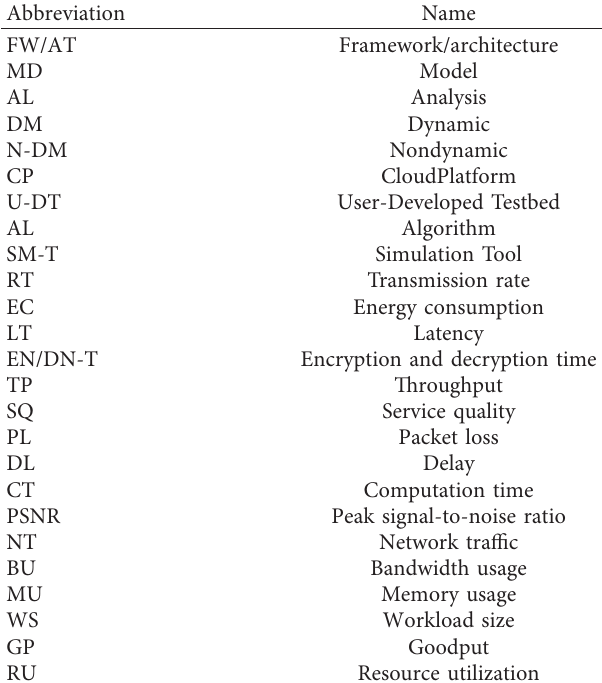
Table 8: List of abbreviations for approaches and metrics